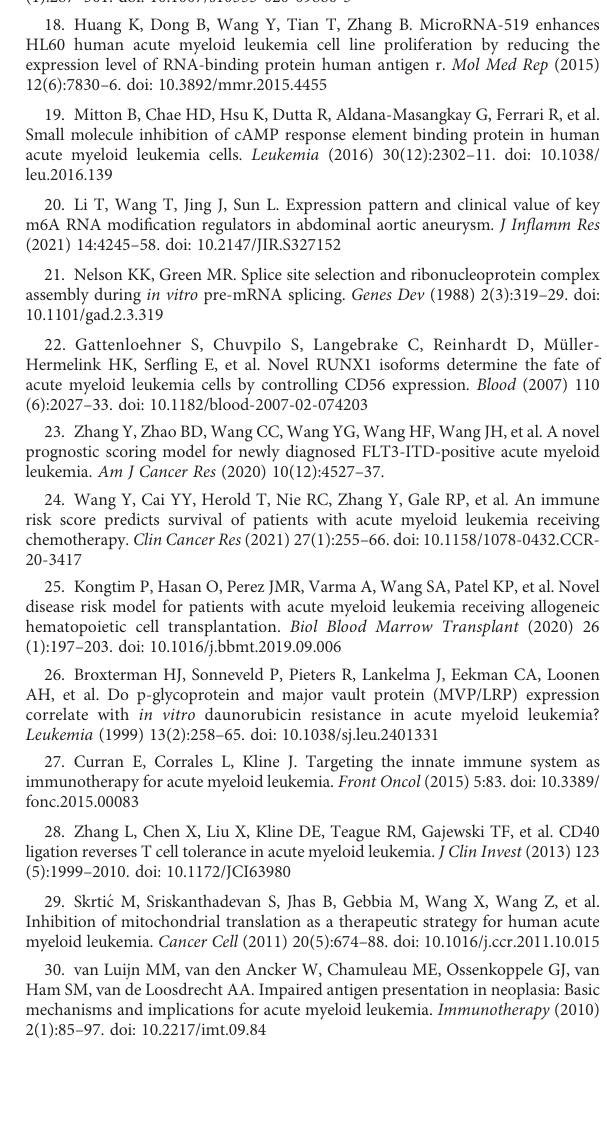
SUPPLEMENTARY TABLE 1 Gene ontology (GO) analysis on Biological Process (BP). SUPPLEMENTARY TABLE 2 Gene ontology (GO) analysis on Cell Components (CC). SUPPLEMENTARY TABLE 3 Gene ontology (GO) analysis on Molecular Functions (BP). SUPPLEMENTARY TABLE 4 Kyoto Encyclopedia of Genes and Genomes (KEGG)